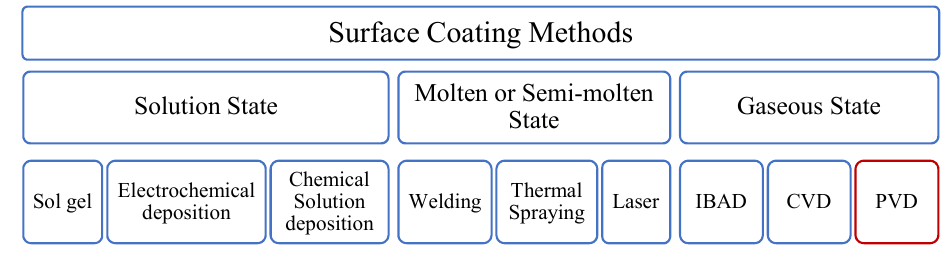
Figure 1. Surface coating methods.